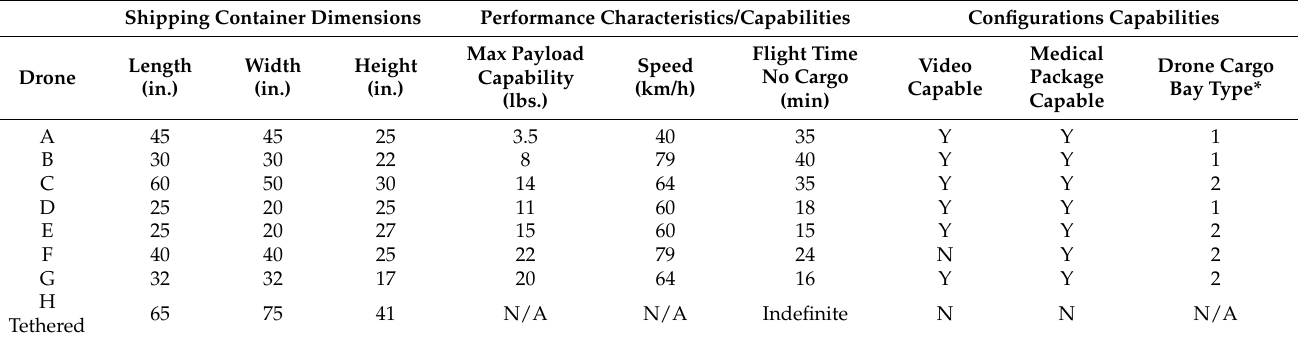
Table 1. UAV configuration of each